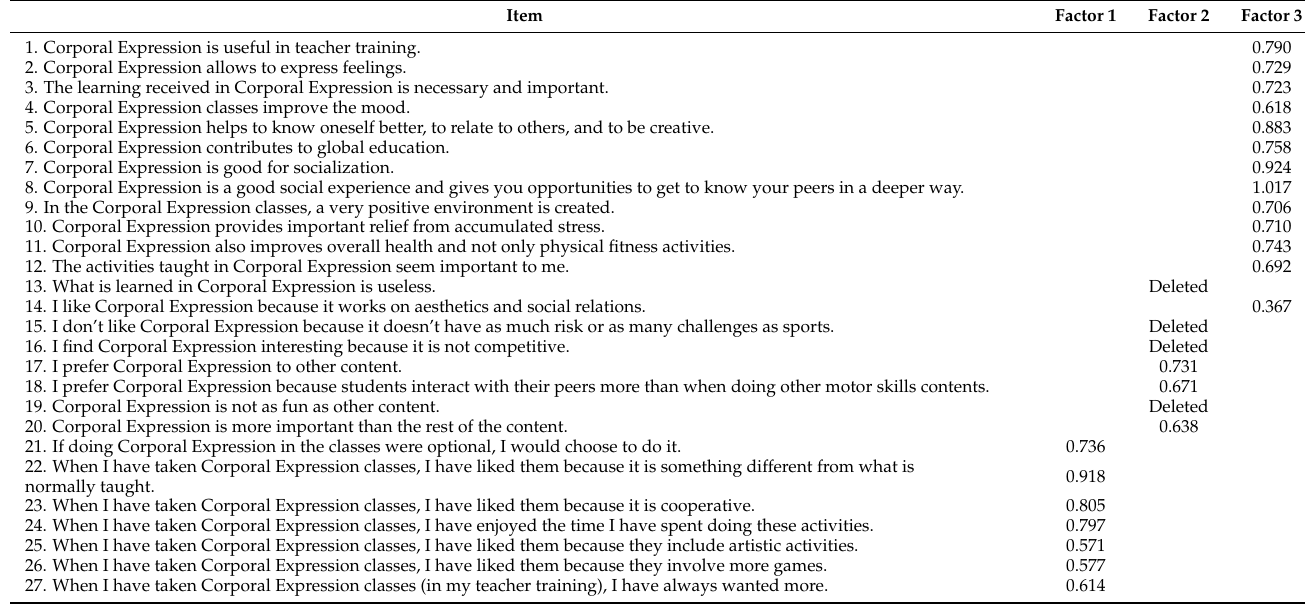
Table 4. Rotated factor solution and factor